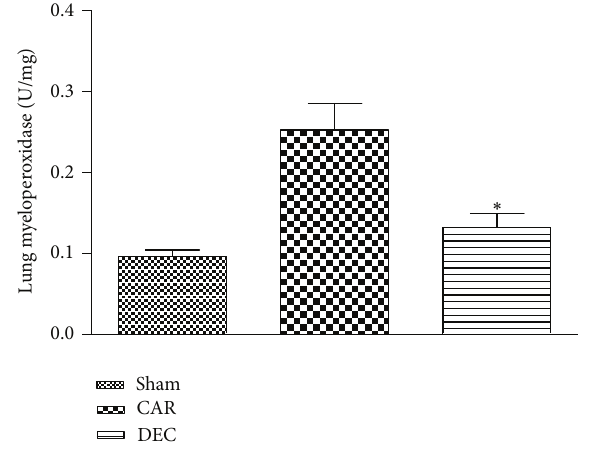
Figure 4: Within 4 h, pleural injection of carrageenan led to an increase in neutrophil accumulation in the lung. DEC treatment significantly inhibited neutrophil infiltration. Data expressed as mean ± S.E.M. from 𝑛 = 8 mice for each group; ∗ 𝑃 < 0.05 versus